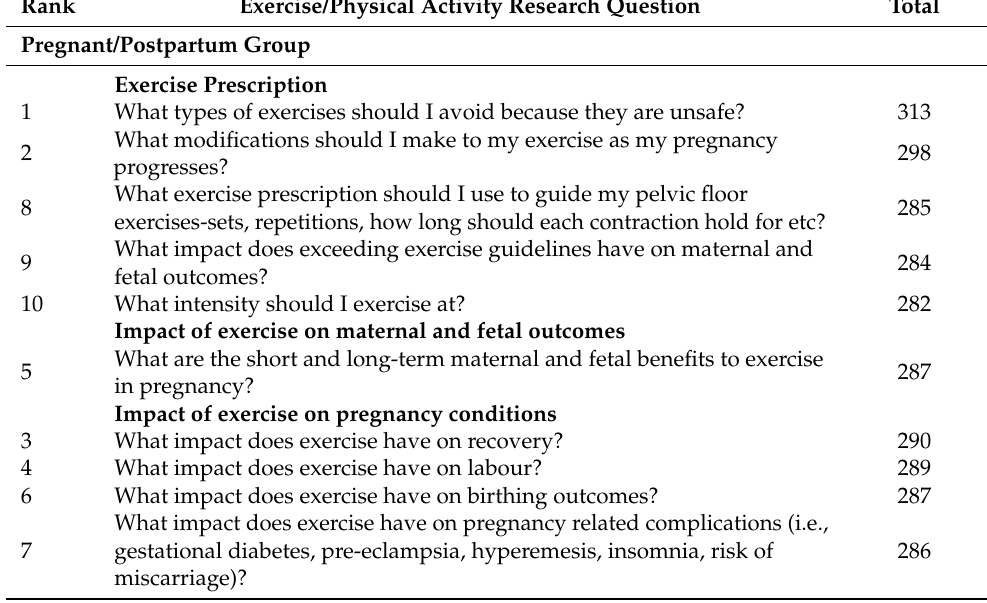
Table 1. Top 10 exercise research priorities by theme according to pregnant/postpartum women, healthcare providers and exercise professionals (for the full list of questions and scores, see Supple- mental Digital Content